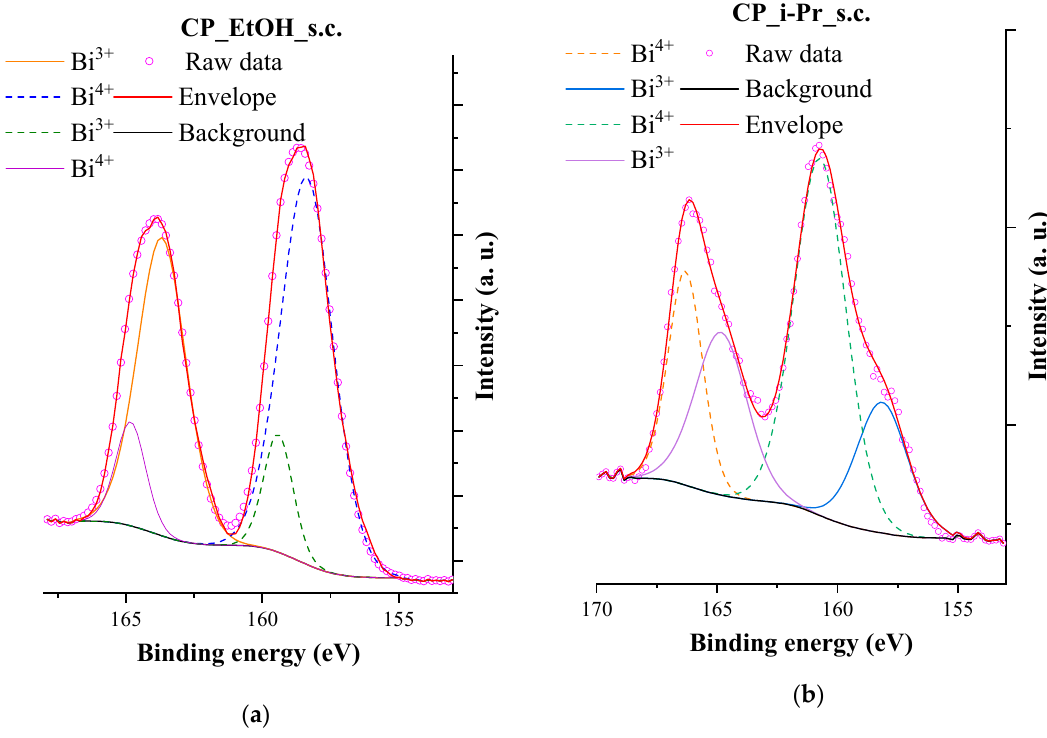
Figure 9. Deconvoluted Bi4f spectra of the CP_EtOH_s.c. ( a ) and the CP_i-Pr_s.c. ( b ), and the identified oxidation states of Bi.